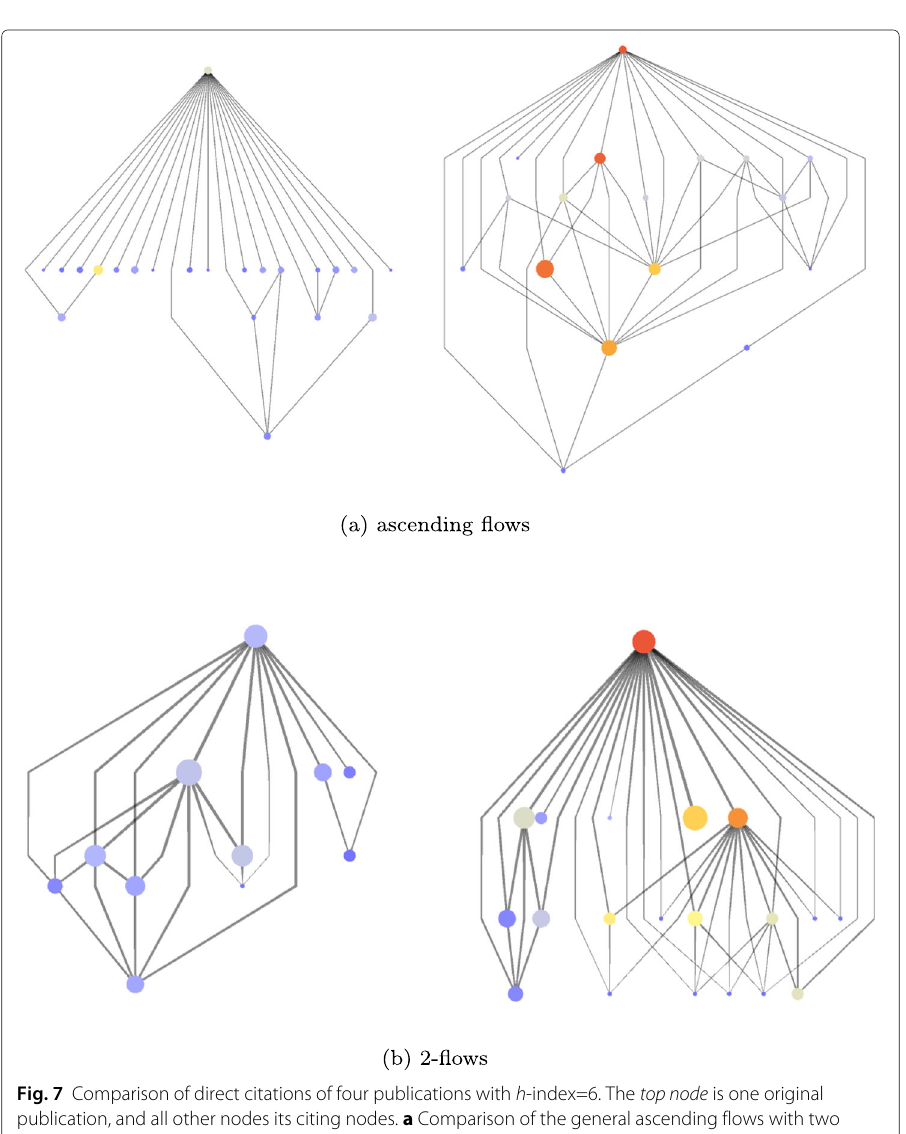
Fig. 7 Comparison of direct citations of four publications with h -index=6. The topnode is one original publication, and all other nodes its citing nodes. a Comparison of the general ascending flows with two extreme values: left ID9204026 (flow=425.4), right ID9201019 (flow=11.2). b Comparison of 2 − flows with two extreme values: left ID9201079 (2 − flow=2.3), right ID9201058 (2 − flow=21.6). Relative node size (between couples of pictures) corresponds to h -index values for each node. Node color, from blue to red , corresponds to, a ascending flow, b 2-flow